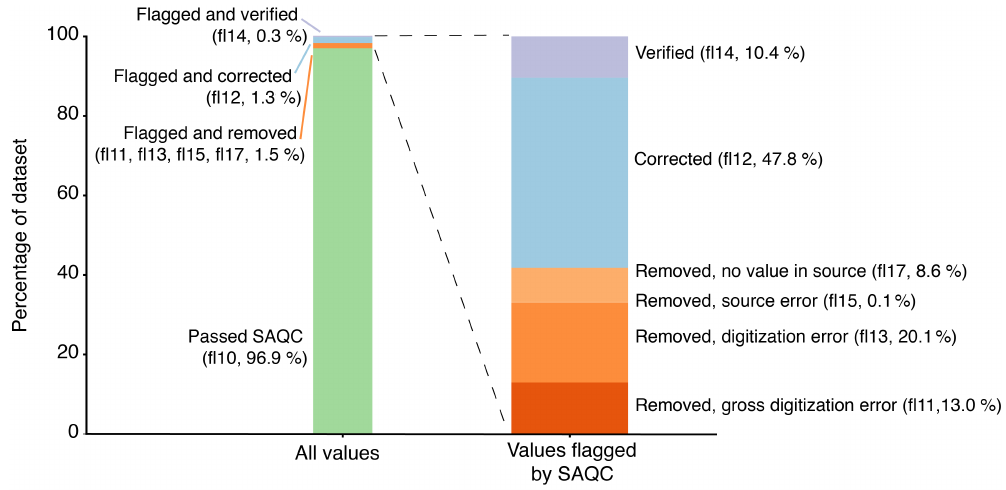
Figure 9. Percentages of flagged and not flagged values derived from SAQC application to this dataset. Panel (a) shows all datasets, while (b) breaks down data that were flagged as possible errors by SAQC. Flag codes given are explained in Table